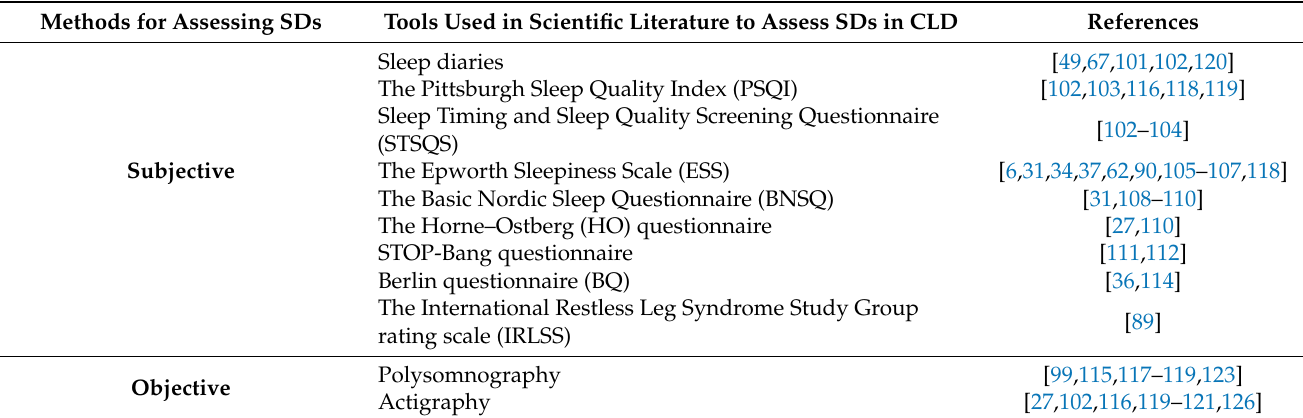
Table 3. Assessment of sleep disorders in